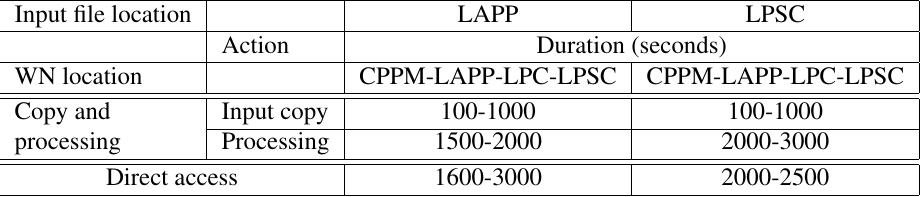
Table 2. Duration of reconstruction job components for di ff erent WN locations, and access mode for input files located at LAPP and